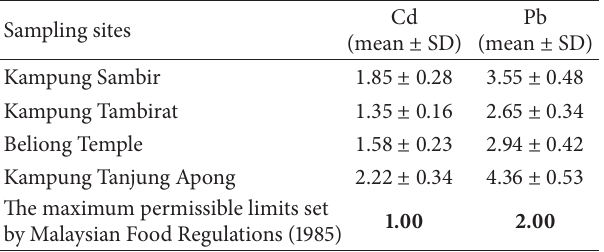
Table 1: The concentrations ( 𝜇 g/g dry wt) of Cd and Pb in blood cockle Anadara granosa from four sites of Sabang River at Asajaya, Sarawak,